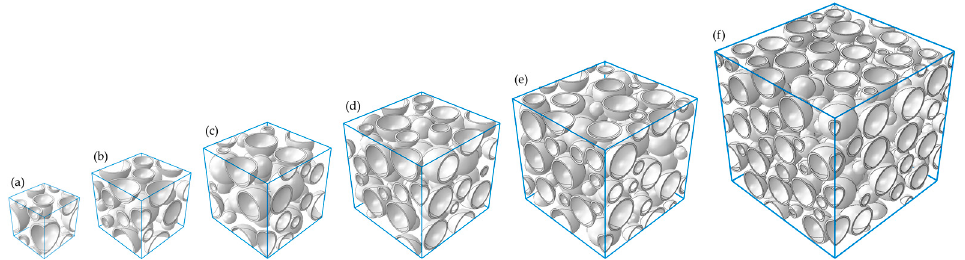
Figure 3. Typical generated models with edge lengths of ( a ) 25 μ m; ( b ) 35 μ m; ( c ) 45 μ m; ( d ) 55 μ m; ( e ) 65 μ m; and ( f ) 85 μ m.